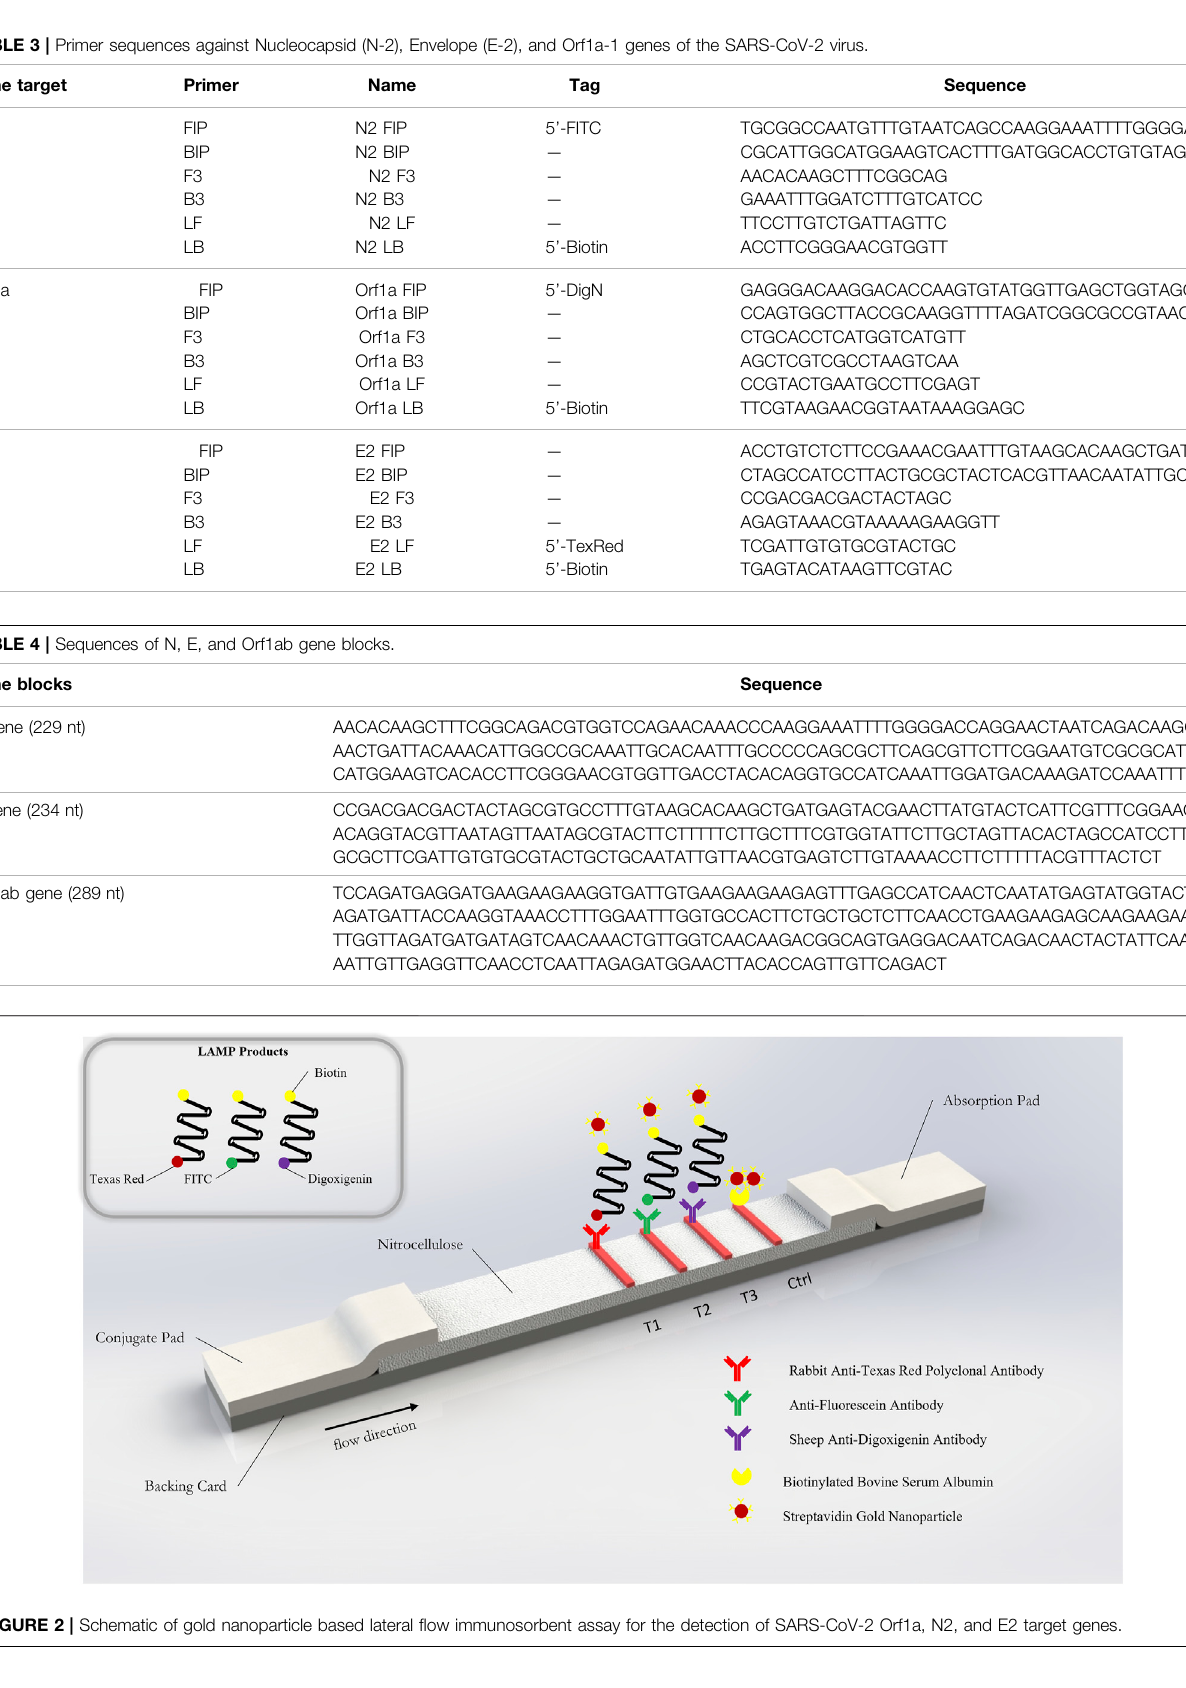
Frontiers in Bioengineering and Biotechnology |